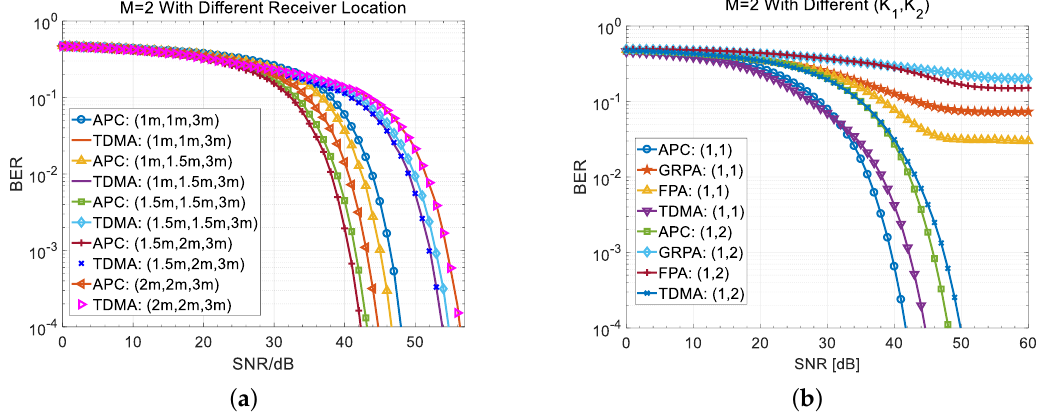
Figure 4. ( a ) Two users’ BER performance comparisons of our proposed APC and TDMA for different photodiode (PD) receiver’s location; ( b ) Two users’ average BER performance comparisons of our proposed APC, gain ratio power allocation (GRPA), fixed power allocation (FPA), and TDMA for different p K 1 , K 2 q .